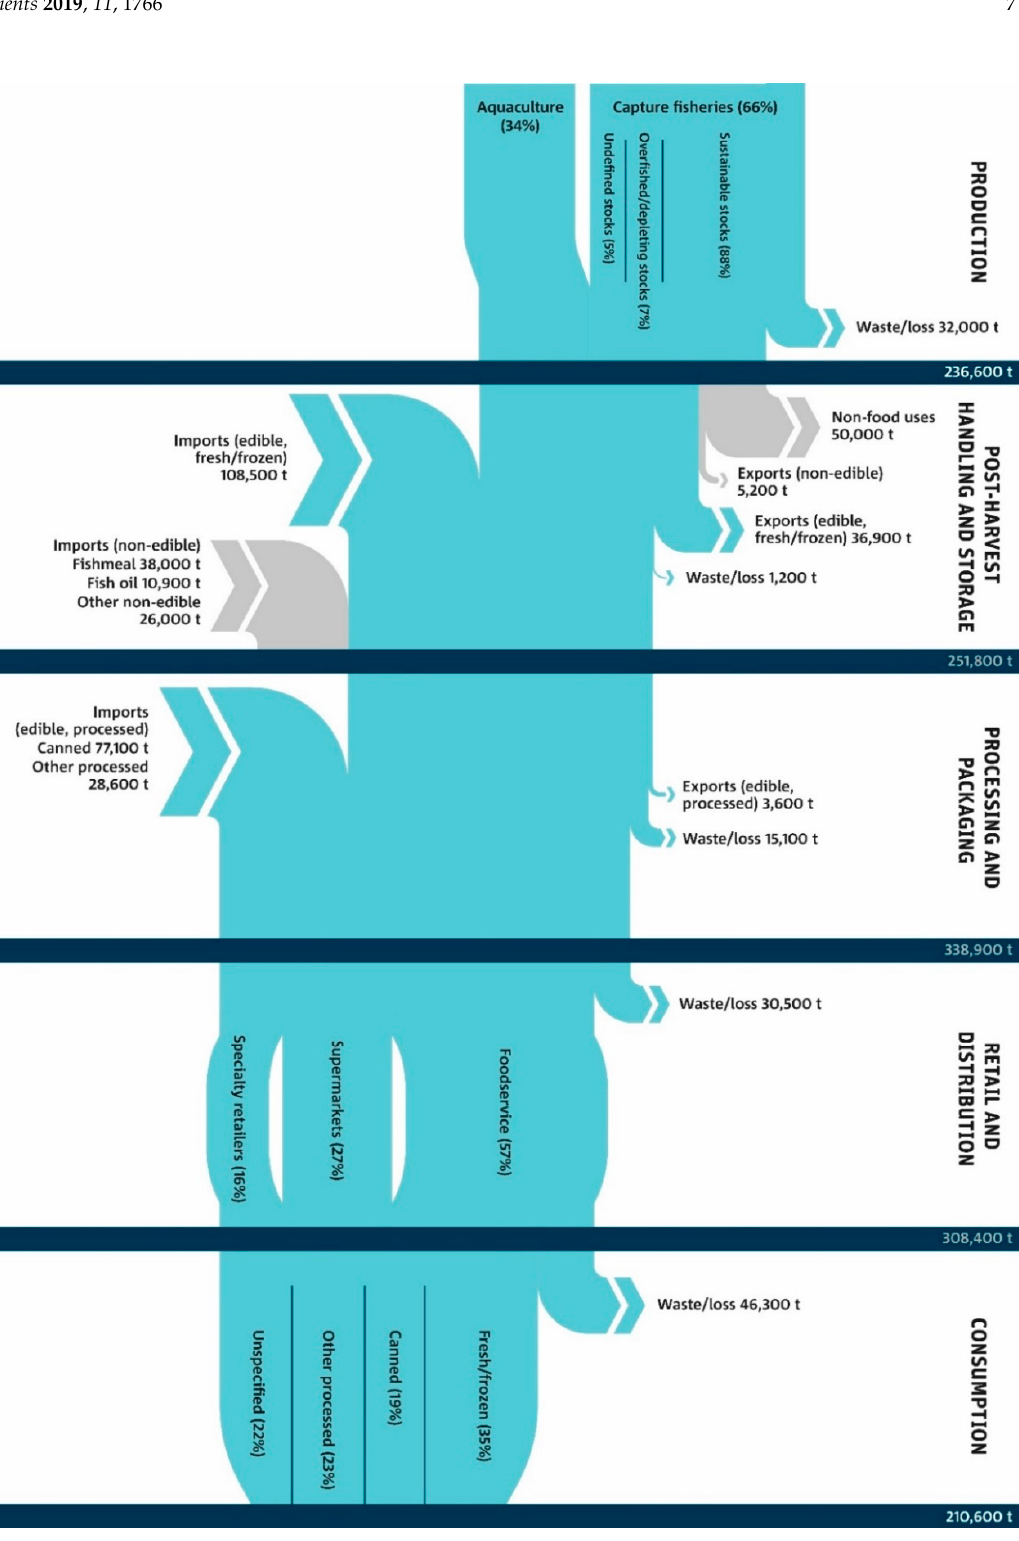
Figure 1. Flow of fish and seafood from production to consumption in Australia in December 2011.